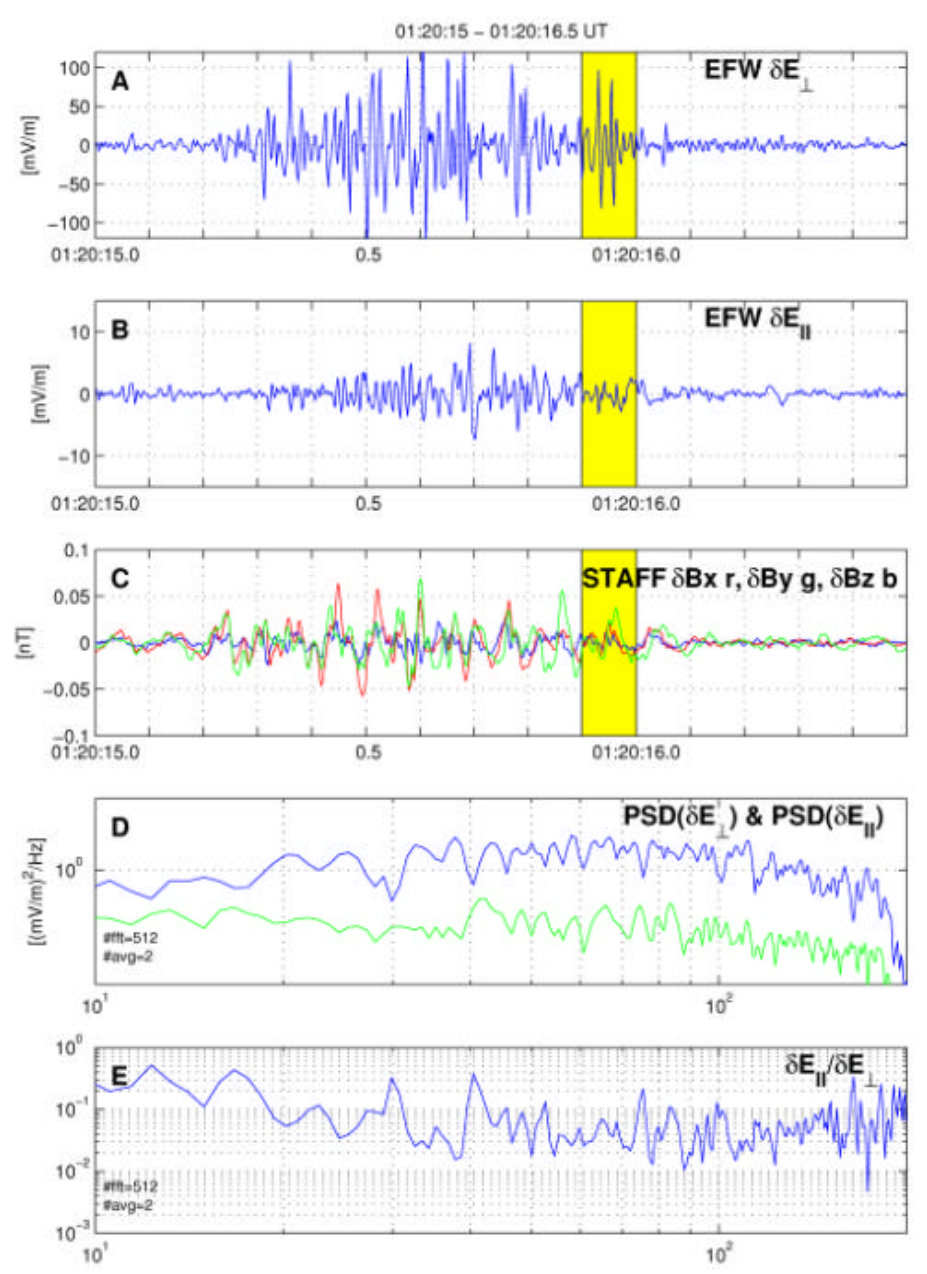
Fig. 6. Data from Cluster spacecraft 3 during part of the interval in Fig. 2; the panels are similar to Fig. 3. Here the perpendicular electric field is clearly dominating. The interval indicated in yellow is studied in detail in Fig.